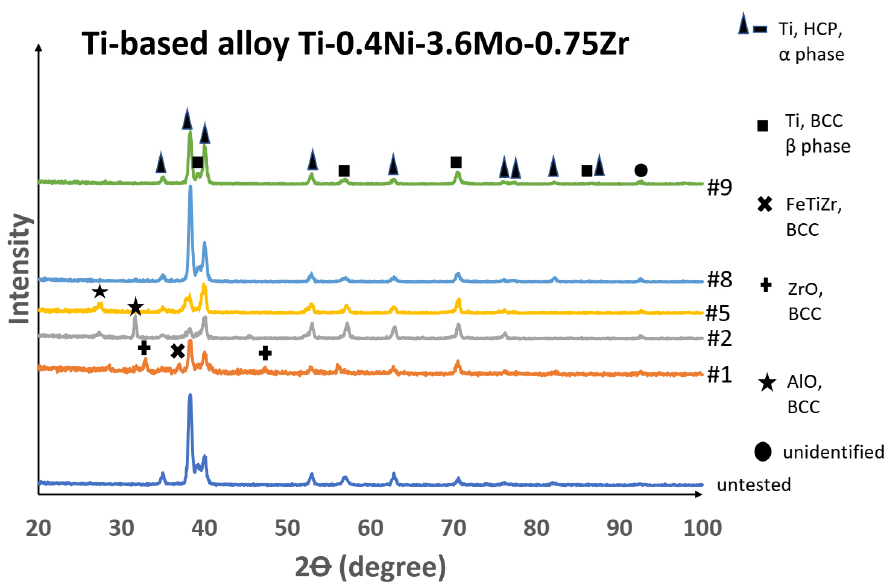
Figure 21. XRD scatters from the titanium alloy from bottom to top: (untested) Unexposed sample, (1) tested sample at the inlet in the first reactor, (2) tested sample in the middle of the first reactor, (5) tested sample in the middle of the second reactor, (8) tested sample in the middle of the third reactor and (9) tested sample at the outlet of the third reactor.